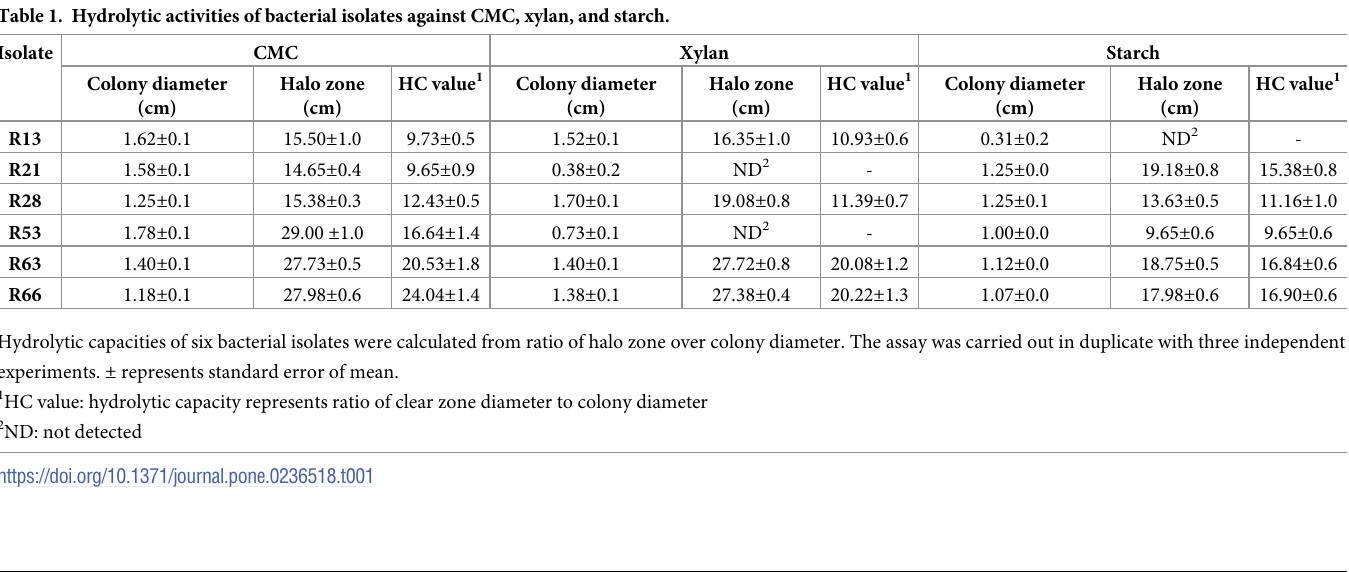
Table 1. Hydrolytic activities of bacterial isolates against CMC, xylan, and starch. Isolate CMC Xylan Starch Colony diameter (cm)